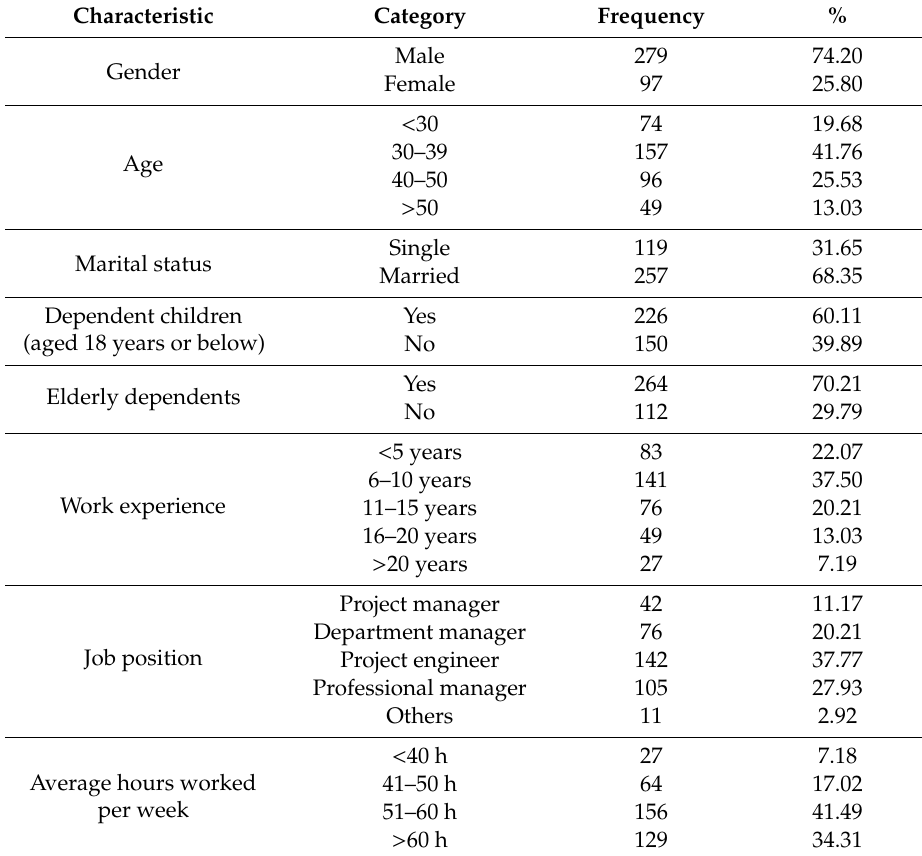
Table 2. The sample structure of the valid